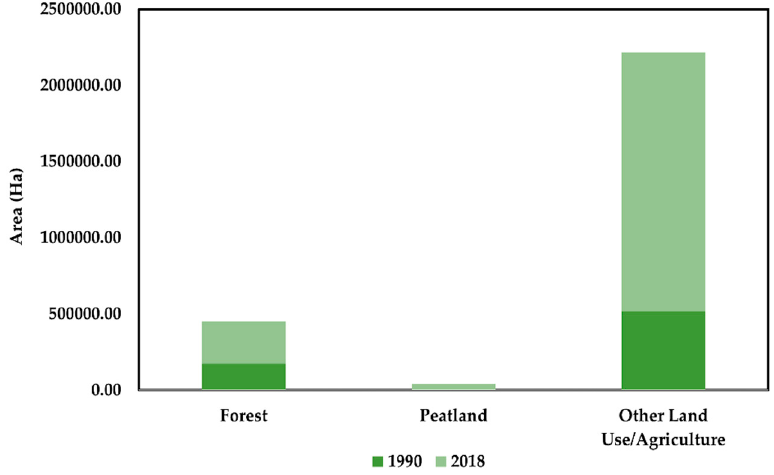
Figure 6. Sarawak oil palm development: ( a ) 1990 as the initial stat, ( b ) 2018, and ( c ) changes in oil palm development.